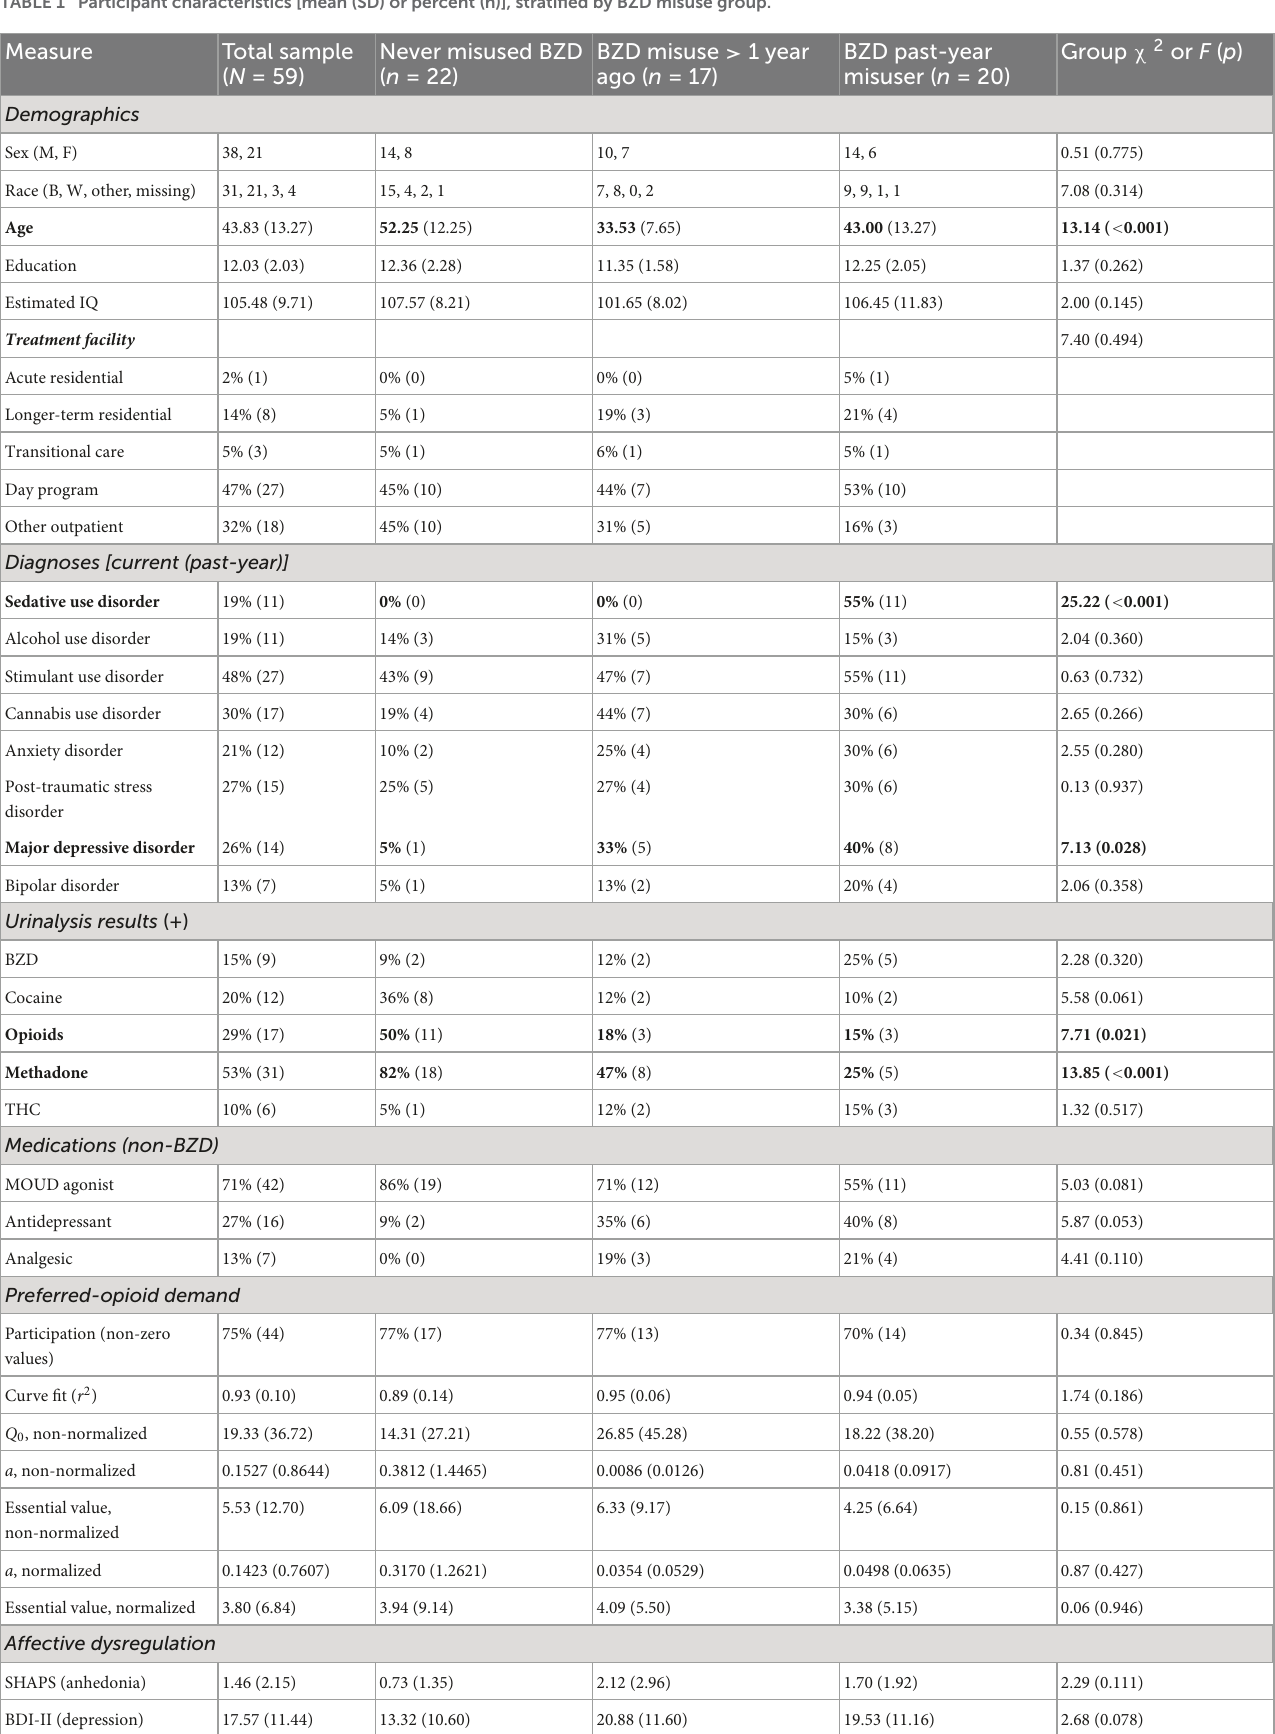
TABLE 1 Participant characteristics [mean (SD) or percent (n)], stratified by BZD misuse